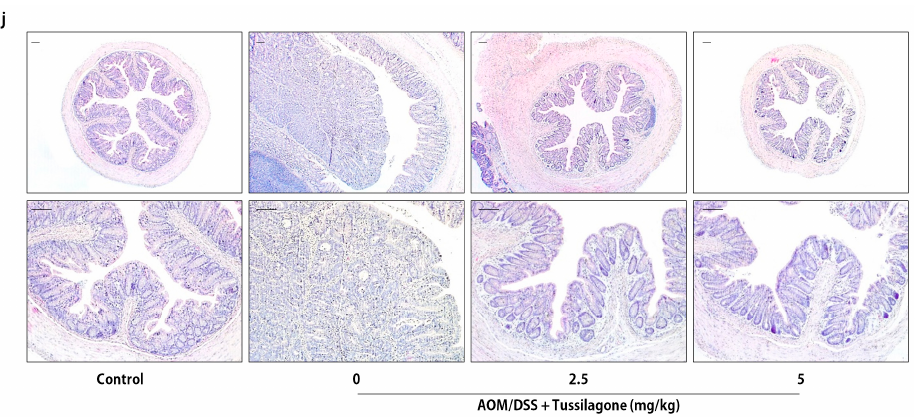
Figure 1. Tussilagone treatment suppressed the AOM / DSS-induced colon carcinogenesis. ( a ) The chemical structure of tussilagone. ( b ) The experimental protocol for the development of a colitis-associated colon carcinogenesis model. ( c ) The weekly recording of the body weights during the experiment and ( d ) the representative macroscopic features of the colons of the mice in each group. ( e ) The number of tumors observed in the colons of mice treated with AOM / DSS and tussilagone. The sizes of tumors were measured and classified as < 3 mm and > 3 mm. ( f ) Total tumor area, ( g ) colon weight, ( h ) colon length and ( i ) the ratio of the colon weight and length per mouse. Results are expressed as the means ± SEM ( n = 9 per group). * P < 0.05, ** P < 0.01, *** P < 0.001, compared with AOM / DSS-treated mice. ( j ) Histopathology of the colonic mucosa by H&E staining (upper, × 40 magnification; lower, × 100 magnification; bar = 100 µ